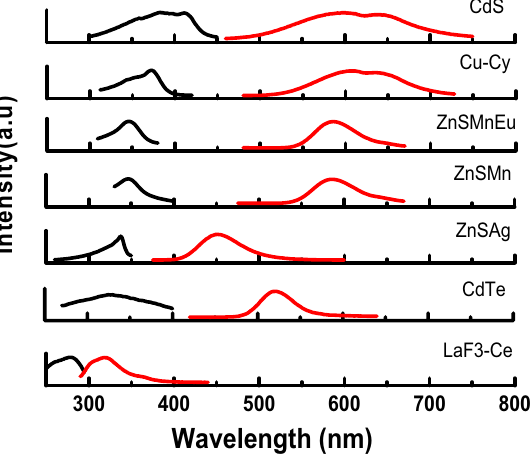
Figure 1. The excitation (black) and emission (red) spectra of CdS, Cu-Cy, ZnS:Mn,Eu, ZnS:Mn, ZnS:Ag, CdTe, and La